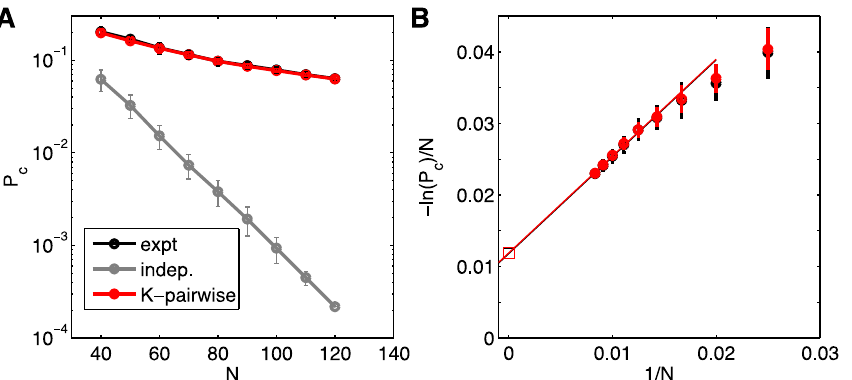
Figure 14. Coincidence probabilities. ( A ) The probability that the combination of spikes and silences is exactly the same at two randomly chosen moments of time, as a function of the size of the population. The real networks are orders of magnitude away from the predictions of an independent model, and this behavior is captured precisely by the K-pairwise model. ( B ) Extrapolating the N dependence of P c to large N .